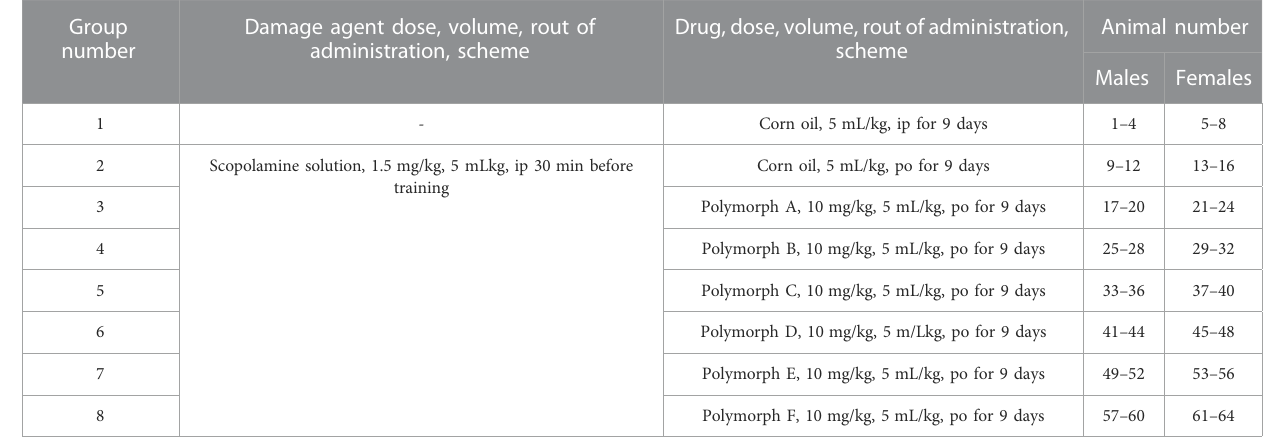
TABLE 3 Groups and doses (cognitive-enhancing nootropic